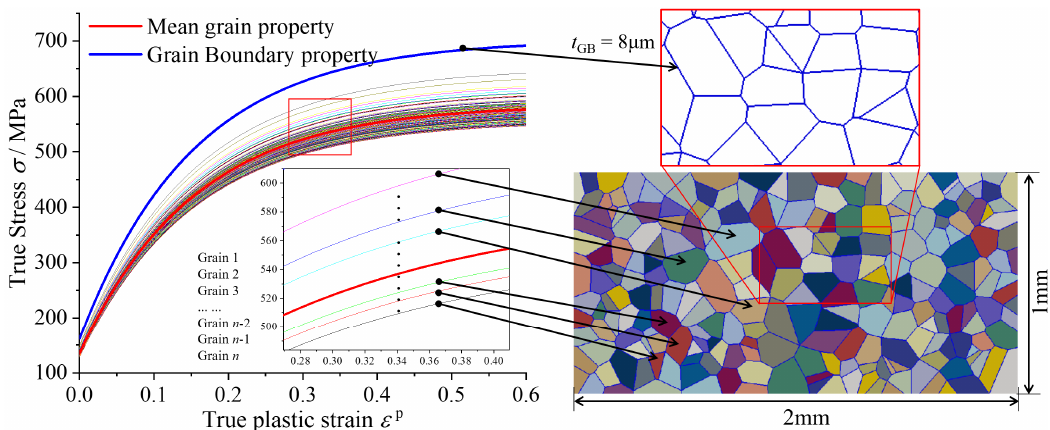
Figure 4. Macroscopic size and properties assignment of polycrystal model.